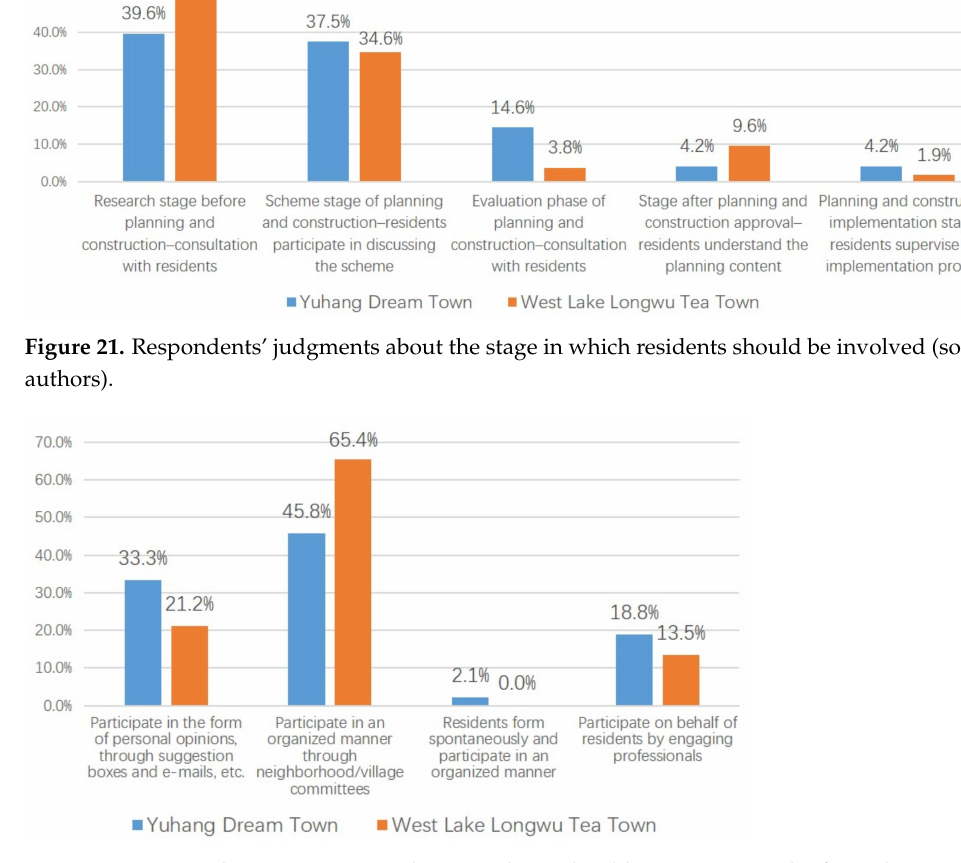
Figure 22. Respondents’ opinions on how residents should participate in the formulation of the planning and construction of the local CT practice (source: